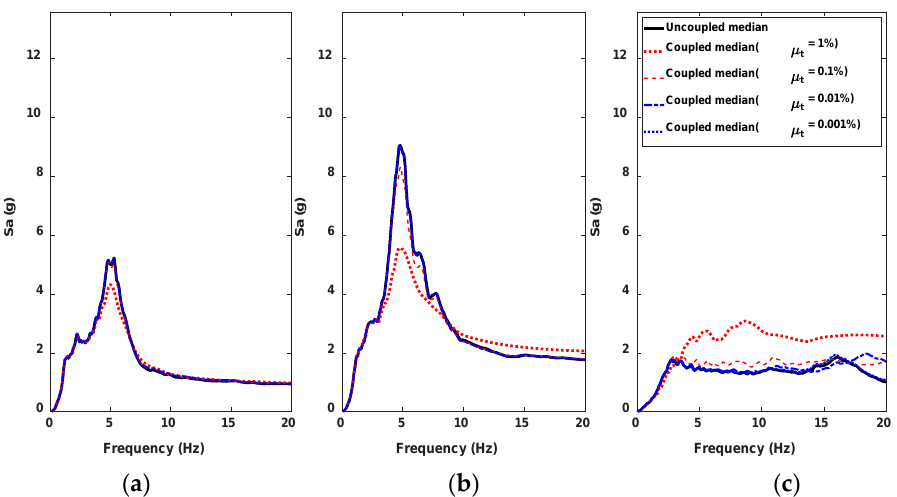
Figure 12. ISRS for 3% equipment damping at the equipment location 1: ( a ) H1; ( b ) H2; ( c ) V.